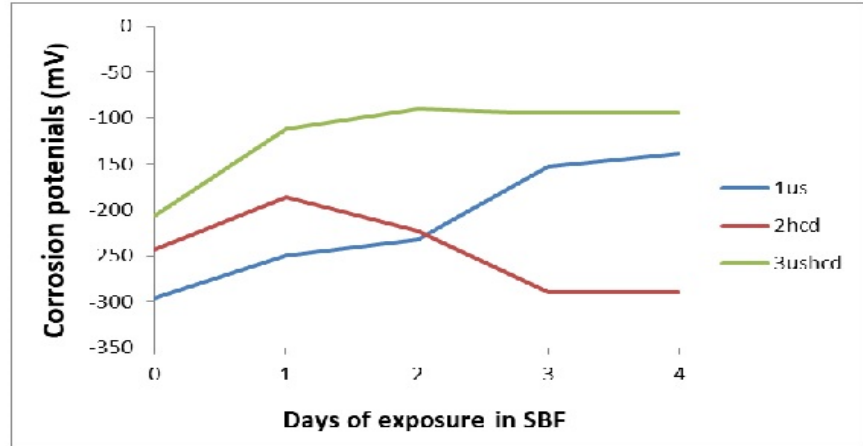
Figure 4. Variation of corrosion potentials with time of exposure.